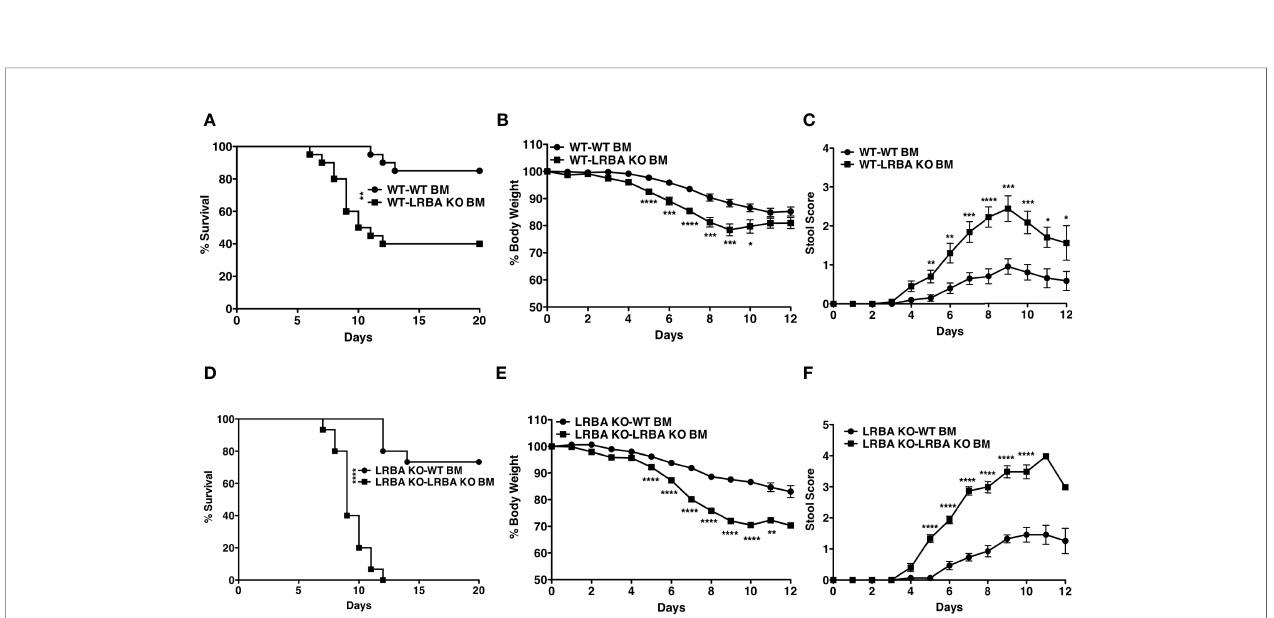
FIGURE 2 | LRBA de fi ciency in the hematopoietic compartment renders mice susceptible to colitis. Lethally irradiated WT mice (129Sv) were reconstituted with WT or LRBA KO BM (129Sv). After 8 weeks, mice were given 3% DSS for 7 days. (A) Survival plot of WT mice reconstituted with WT BM cells (WT-WT BM) vs. WT mice reconstituted with LRBA KO BM cells (WT-LRBA KO BM), (B) % weight loss, and (C) stool score. Lethally irradiated LRBA KO mice were reconstituted with WT or LRBA KO BM. After 8 weeks, mice were given 3% DSS for 7 days. (D) Survival plot, (E) % weight loss, and (F) stool score of LRBA KO mice reconstituted with WT BM cells (LRBA KO-WT BM) or LRBA KO BM cells (LRBA KO-LRBA KO BM). (A – E) Pooled data from 2 independent experiments. For panels (A – C) , n = 20, whereas n = 15 for (D – F) . *p < 0.05, **p < 0.01, ***p < 0.001, ****p < 0.0001. WT, wild type; KO, knockout; DSS, dextran sulfate sodium; BM, bone marrow.